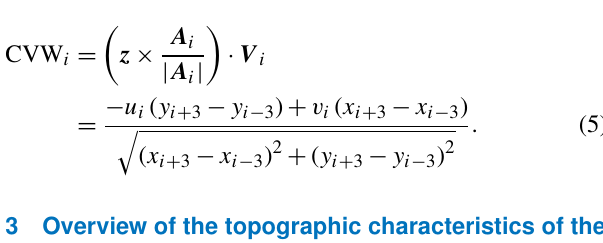
centre line is calculated using Eq.